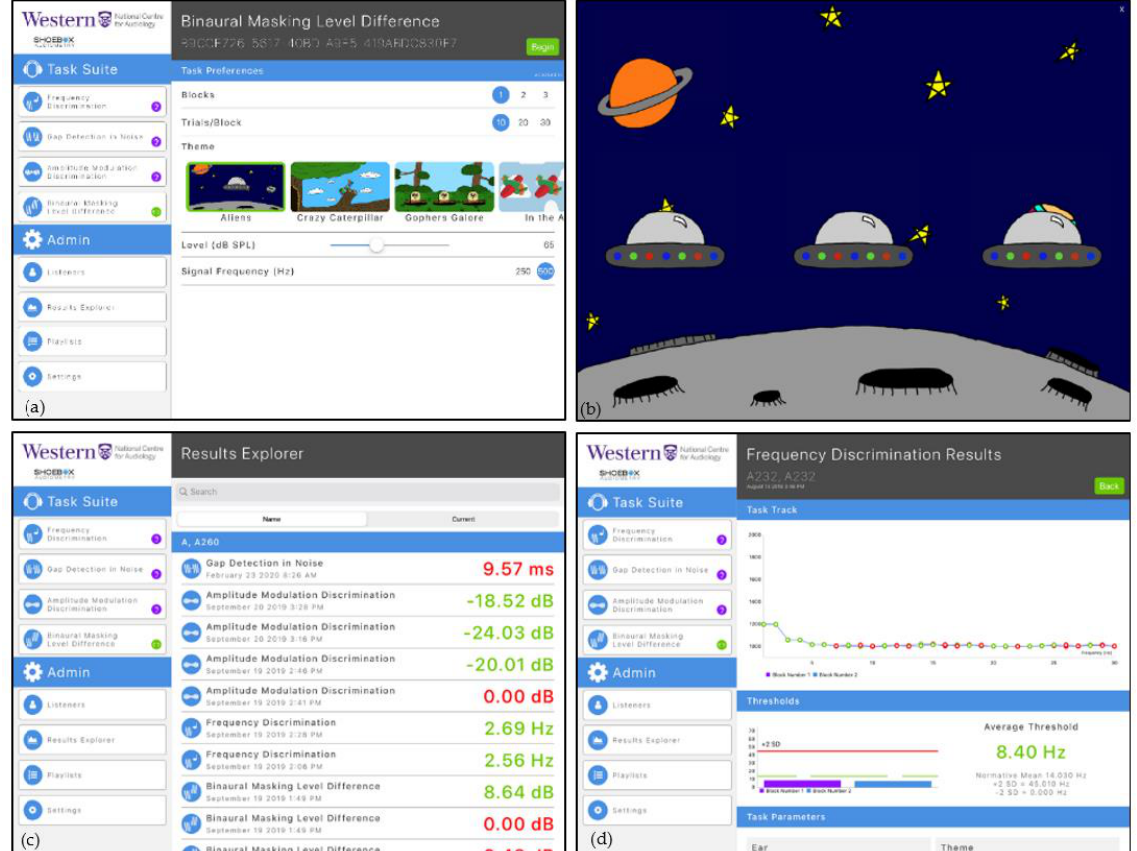
Figure 2. Screenshots from the iPAAS app. ( a ) The main UI where the tester selects the appropriate tests and its parameters; ( b ) cartoon animation during the test; ( c ) color-coded summary of all the test results in the database; and ( d ) trial-by-trial results from a participant for the frequency discrimination test with two blocks.